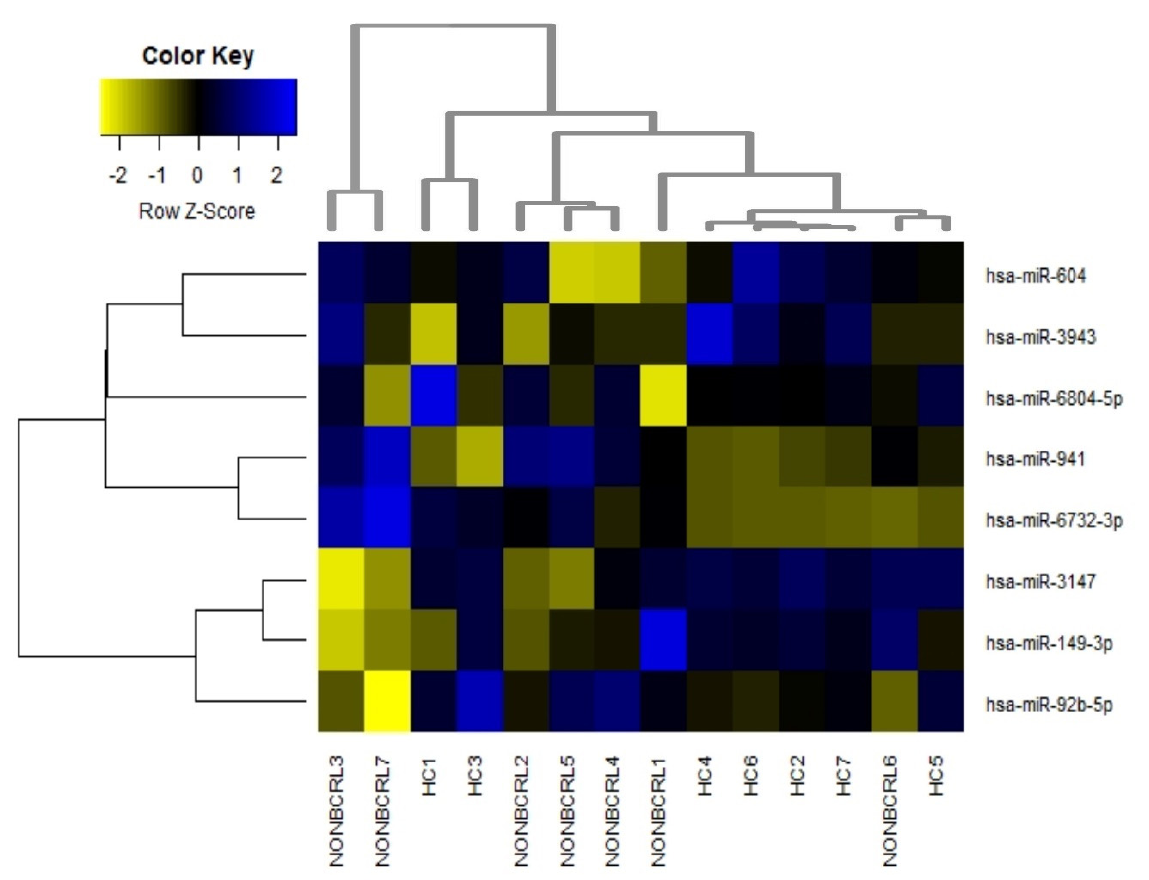
Figure 2. Differentially expressed miRNAs in non-BCRL vs. HCs. Supervised hierarchical cluster heatmaps were performed on eight miRNAs significantly altered between non-BCRL and HCs. Similarity in the expression patterns between miRNAs (branches shown on the left-hand panel) was measured using Pearson’s correlation. Distances between clustered branches represent the average distances between miRNAs (right-hand panel) and individual samples in the cluster (bottom panel). The height of each branch represents the degree of similarity within the cluster. MiRNAs are colored according to their expression level, where upregulated expression is represented by blue, downregulated expression is represented by yellow, and equal expression is represented by black. HC healthy controls; non-BCRL breast cancer without lymphedema. Table 3. Differentially expressed miRNAs in non-BCRL compared to HCs revealed by small RNA- sequencing. The FDR-adjusted p < 0.05 (Benjamini–Hochberg) was considered statistically signifi- cant.